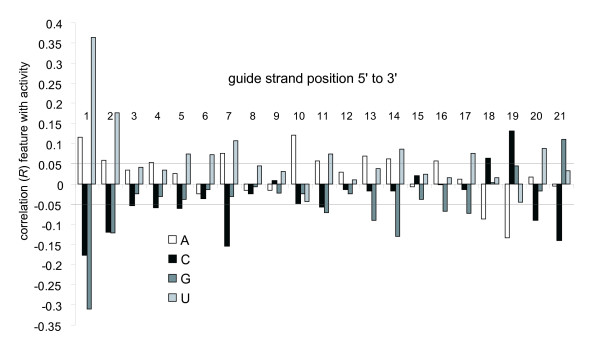
Guide strand position specific base composition correlation coefficients with RNA interference activities. Positive correlations can be interpreted as the presence of the nucleotide at the position leads to greater RNAi activity, while negative correlations are the presence of the nucleotide resulting in a decreased RNAi activity. Position 1 is the 5' most position of the guide strand.